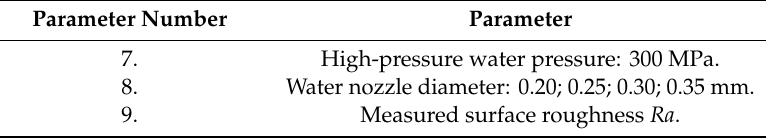
Table 5. Additional secondary cutting parameters of the test sample.